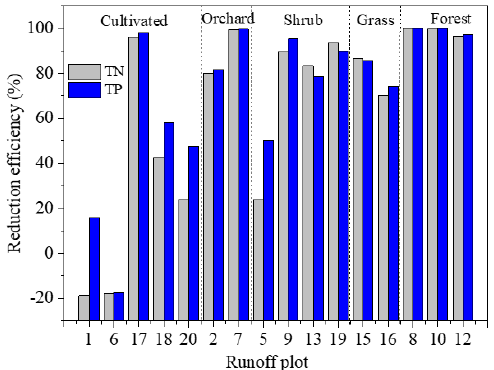
Figure 8. Reduction efficiencies of annual TN and TP losses by soil conservation measures. The numbers on the X axis represent plots. For example, the first number 1 represents Plot 1.